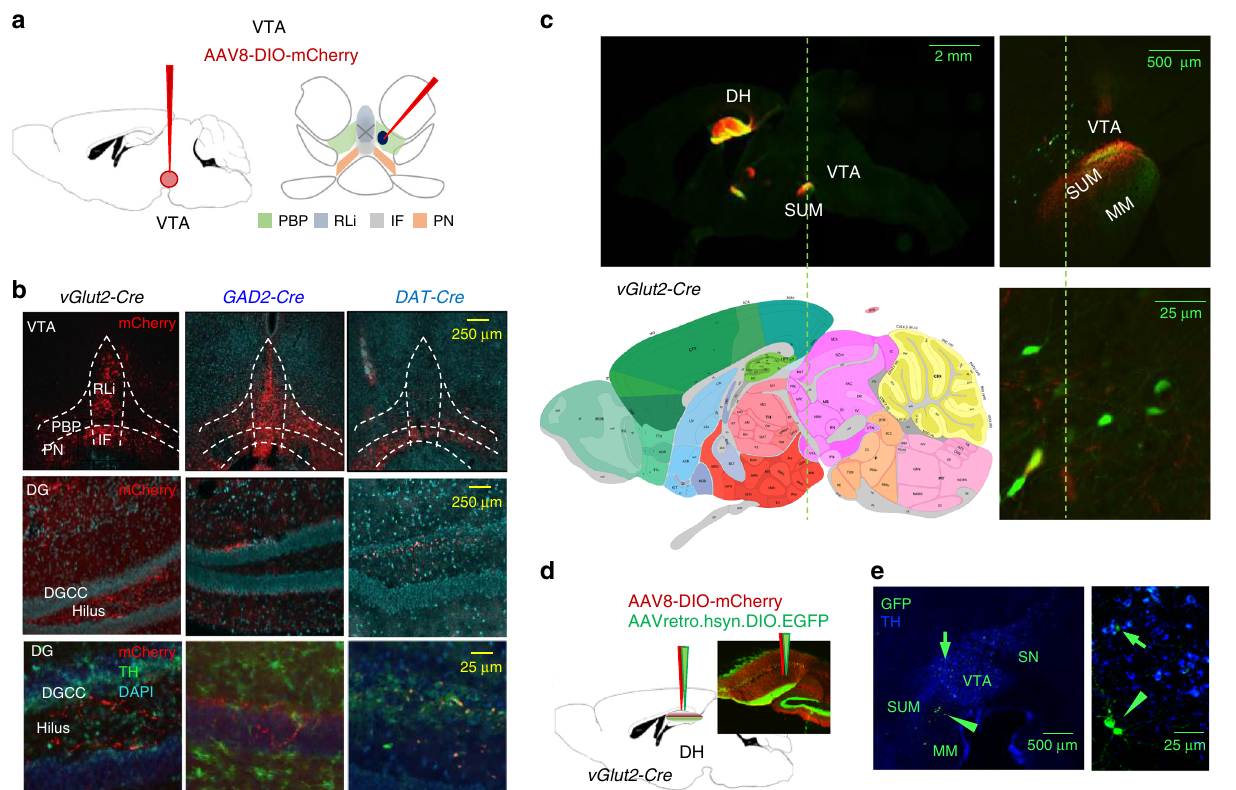
Fig. 1 VTA → DH afferents mainly consists of glutamatergic projections. a Sagittal (left) and coronal (right) schematics of the neuroanatomical sites of Cre-dependent reporter virus injection in vGlut2-Cre ( n = 3), GAD2-Cre ( n = 3), and DAT-Cre ( n = 3) mice. b Images showing virus infection (mCherry signals, red) in the VTA (top) and dentate gyrus of the hippocampus (middle). Bottom panel shows lack of co-localization of dentate gyrus mCherry signals with tyrosine hydroxylase (TH, green). In all sections DAPI (blue) is used as nuclear counterstain. Terminals from VTA were the most prominent in vGlut2- Cre mice. c Rostral VTA neurons localized above SUM showed prominent labeling with the retrograde tracer AAVretro.hsyn.DIO.EGFP (green) and were identi fi ed as DH-projecting VTA neurons. Different magni fi cations are shown top left and right. Bottom left: Localization was determined based on the Allen Brain Atlas. Credit for image: Allen Institute. d Schematics (left) and image (right) of injection of anterograde and retrograde viral tracers into DH ( n = 4). e Retrogradely labeled DH-projecting VTA neurons were localized dorsal to SUM, as con fi rmed by TH immunostaining (blue). DG dentate